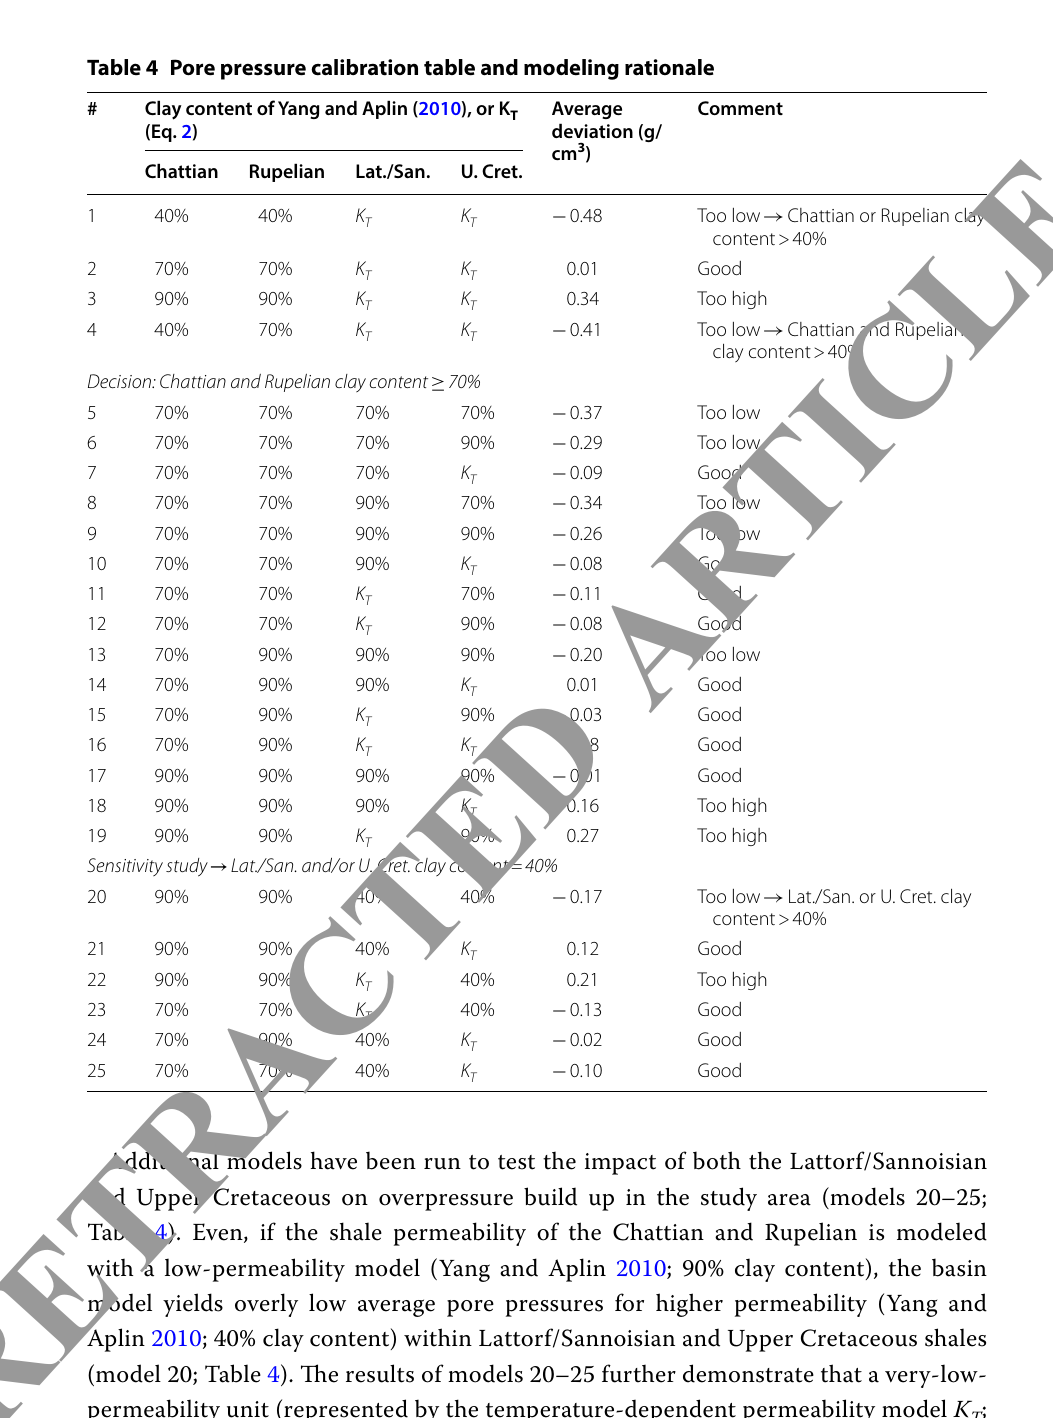
Average Comment deviation (g/ cm 3 )